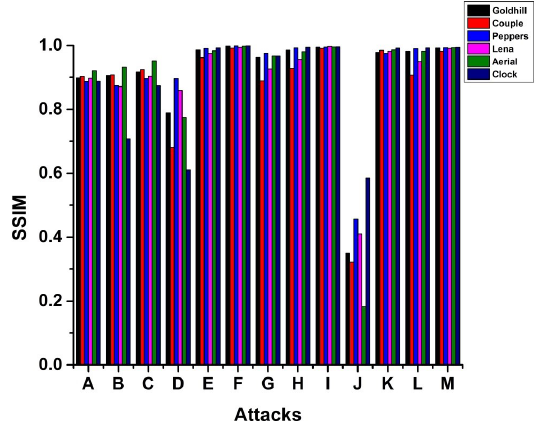
Figure 7: SSIM Values Evaluated for Proposed Technique under Several Attacks (A) Salt & pepper Noise (0.004) (B) Speckle Noise (0.001) (C) Gaussian Noise (0, 0.0002) (D) Histogram equalization (E) Sharpening (F) Gaussian Filter (3 × 3) (G) Average Filter (3 × 3) (H) Median Filter (3 × 3) (I) JPEG Compression (90) (J) Rotation (3 ∘ ) (K) Gamma Correction (0.8) (L) Scaling (0.5, 2) (M) JPEG Compression (80) + Scaling